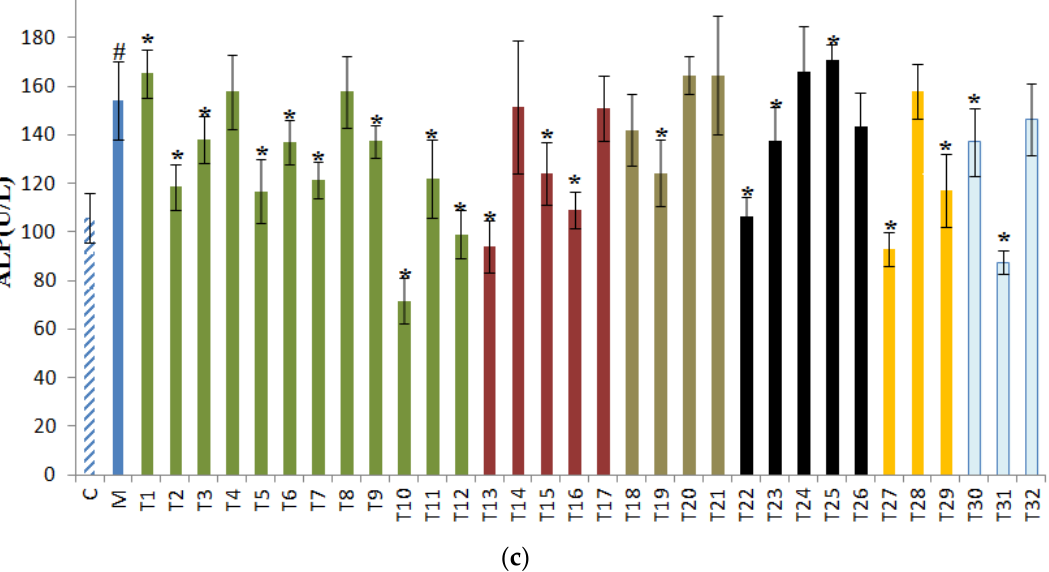
Figure 1. The effects of 32 teas on serum ( a ) alanine transaminase (ALT); ( b ) aspartate transaminase (AST); ( c ) alkaline phosphatase (ALP) levels. # p < 0.05, the model group versus the control group. * p < 0.05, the treatment group versus the model group. C, the control group; M, the model group; T1,